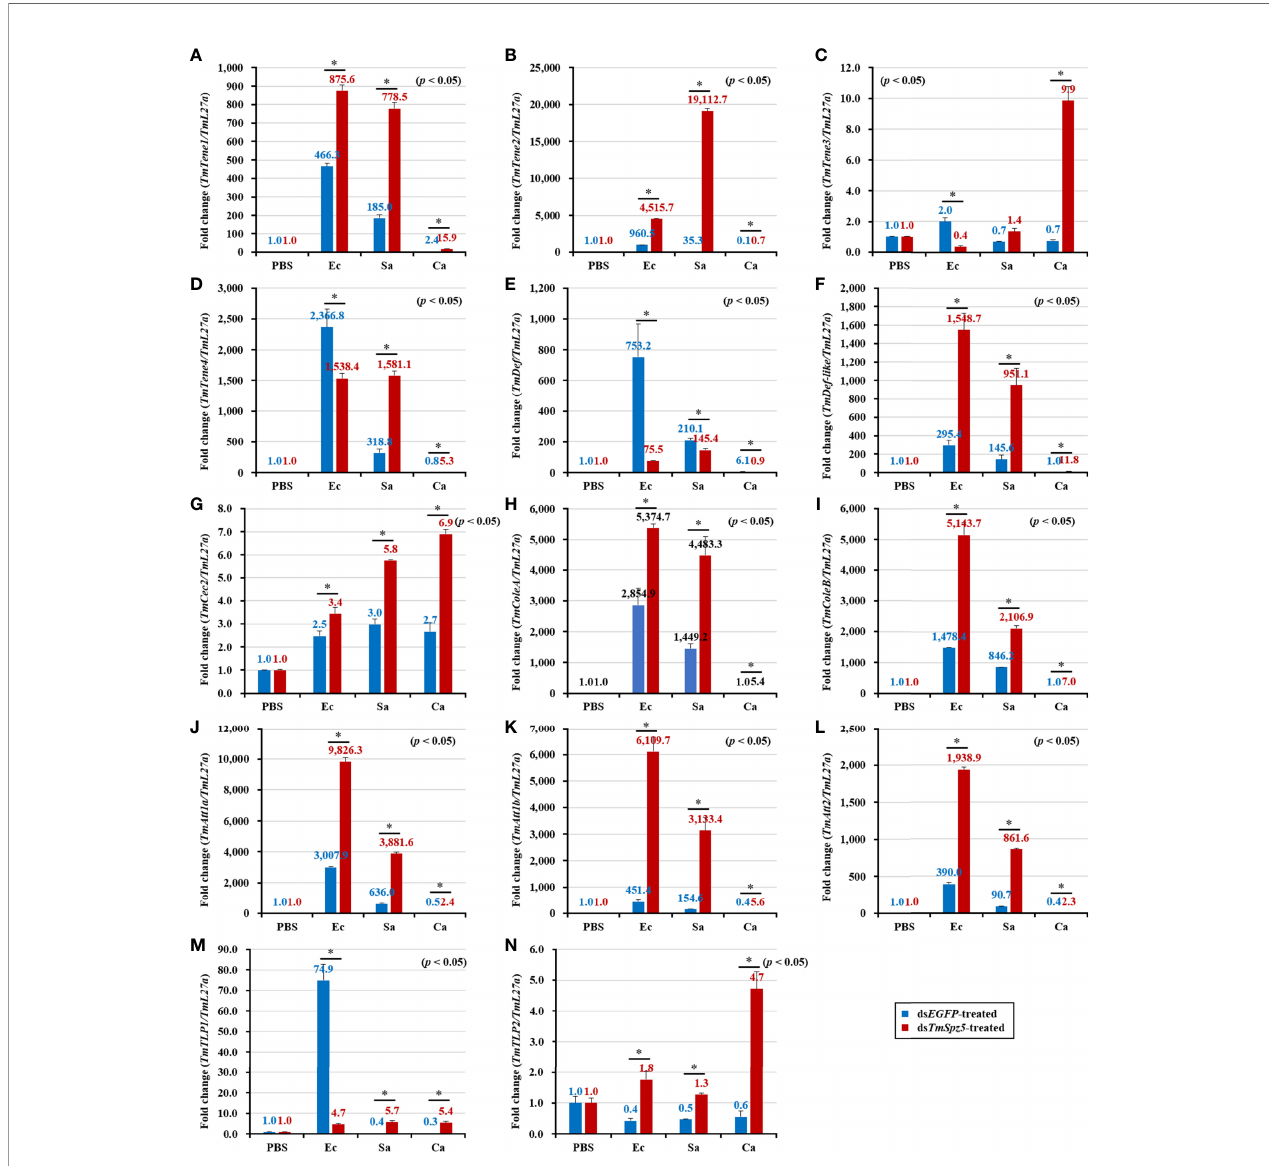
FIGURE 9 | Antimicrobial peptide expression patterns in the fat bodies of ds TmSpz5- treated T. molitor larvae in response to microbial challenge. At 24 h post- infection by E . coli (Ec), S. aureus (Sa), and C. albicans (Ca), the mRNA levels of TmTene1 (A) , TmTene2 (B) , TmTene3 (C) , TmTene4 (D) , TmDef (E) , TmDef-like (F) , TmCec2 (G) , TmColeA (H) , TmColeB (I) , TmAtt1a (J) , TmAtt1b (K) , TmAtt2 (L) , TmTLP1 (M) , and TmTLP2 (N) were evaluated by qRT-PCR. PBS was administered to the non-infected control group. ds EGFP was injected as a negative control, and TmL27a expression was measured as an internal control. All experiments were performed in triplicate. Asterisks indicate signi fi cant differences between ds TmSpz5 - and ds EGFP -treated groups determined using Student ’ s t-test ( p <